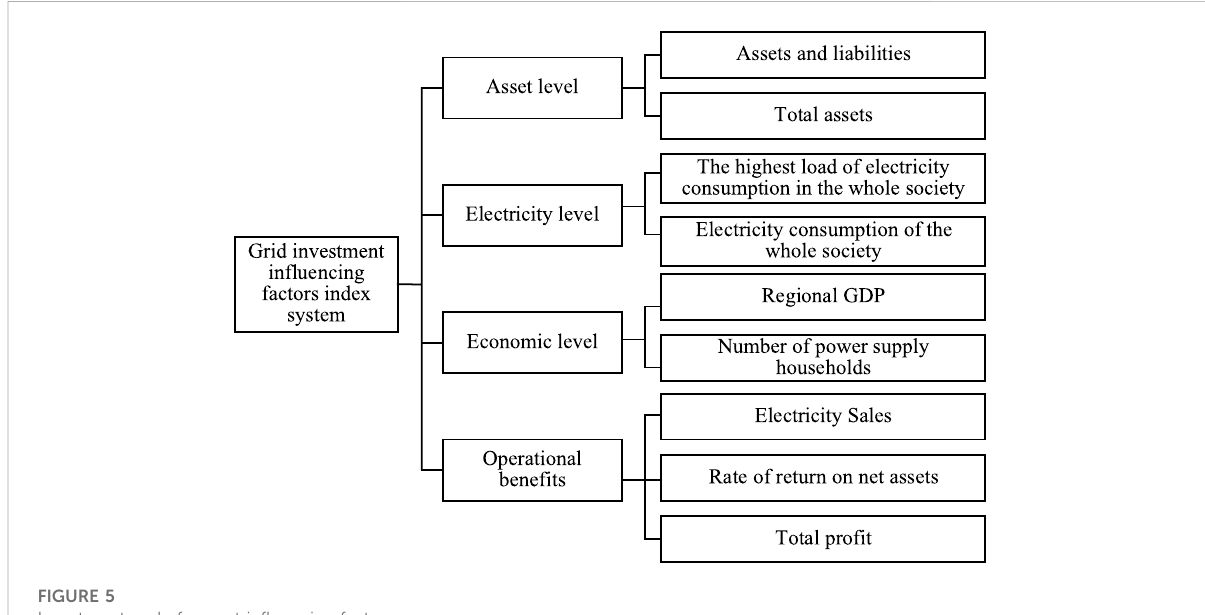
FIGURE 5 Investment scale forecast in fl uencing factors.